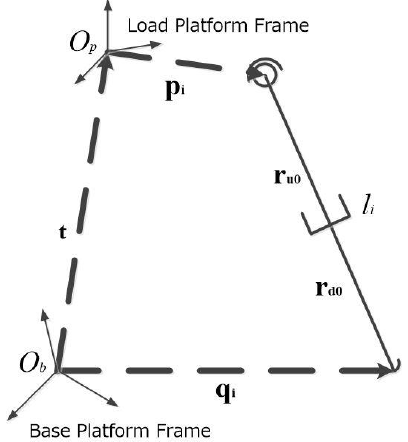
Figure 13. Kinematic relationship of Stewart platform.